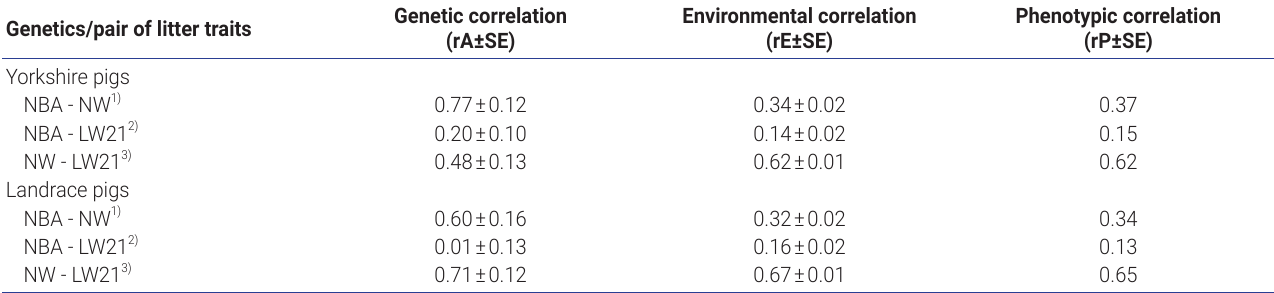
Table 4. Genetic, environmental, and phenotypic correlations among the litter traits of number born alive, number weaned, and litter weight at the 21st day in Danish Yorkshire and Landrace pigs Genetics/pair of litter traits